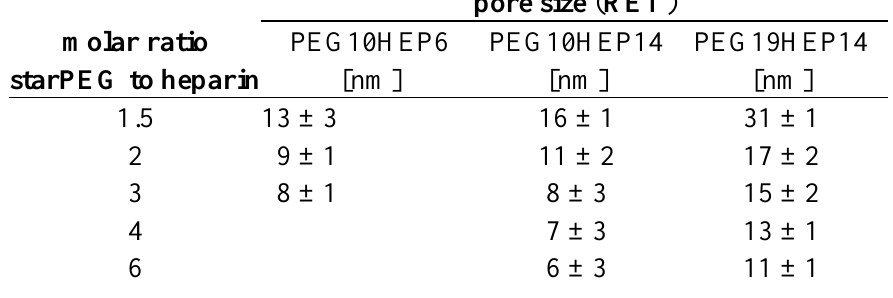
Table 1. Mesh size of various starPEG-heparin matrices calculated from the storage moduli of the swollen gels by Equation 2